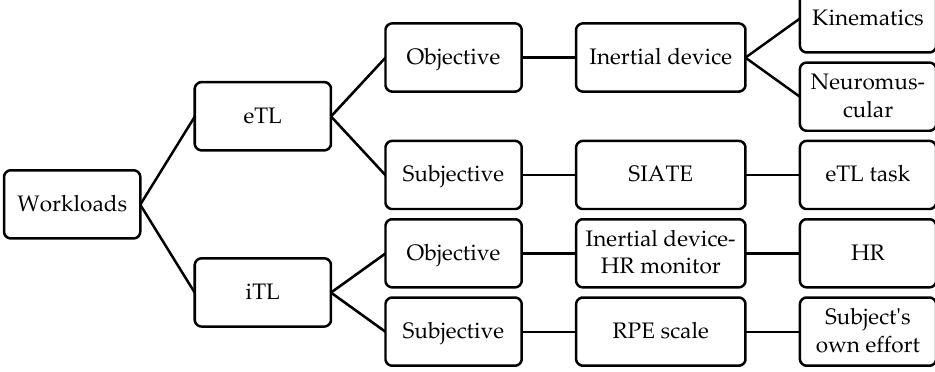
Figure 1. Classification of the workloads and measuring instruments. RPE, Ratings of Perceived Exertion; eTL, external load; iTL, internal load; HR, heart rate; SIATE (acronym in Spanish), Integral System for the Analysis of Training Tasks.